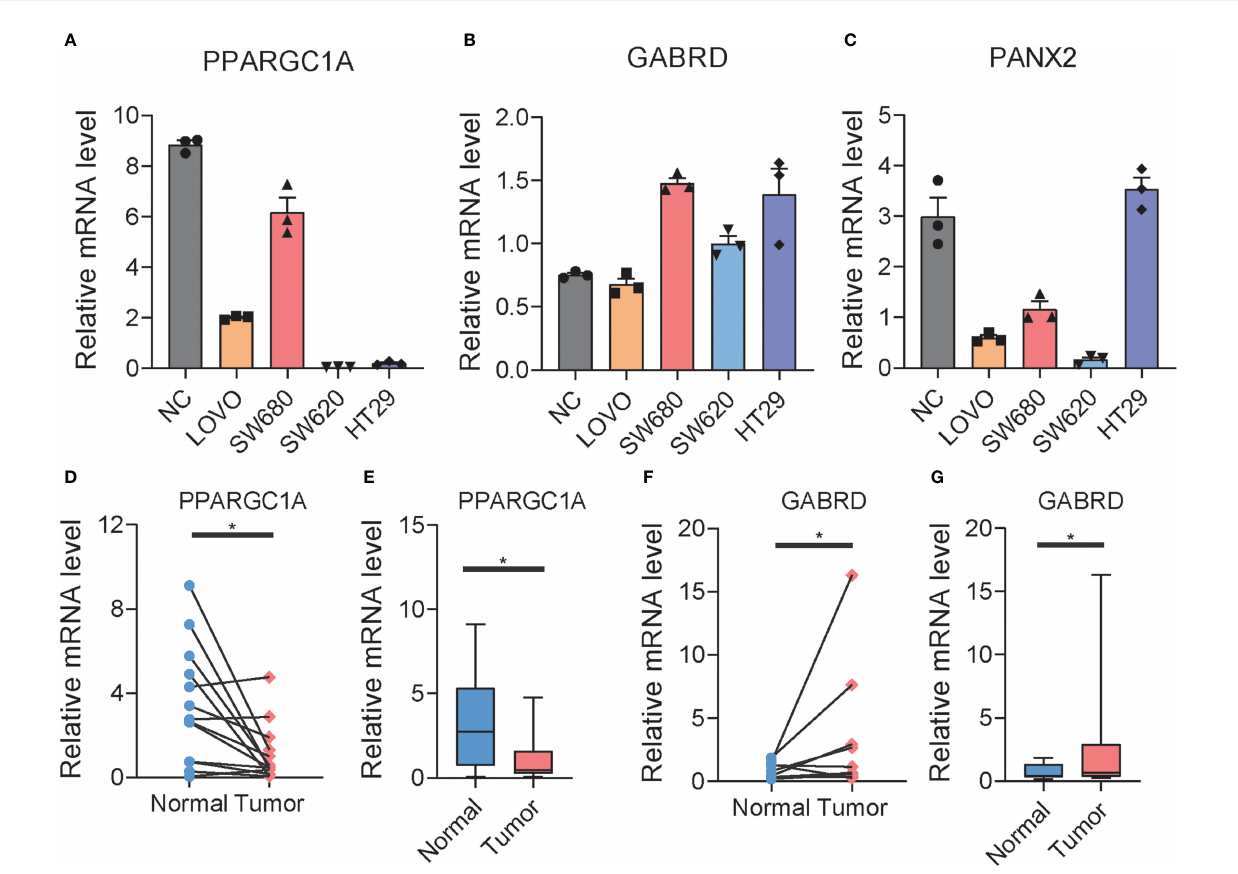
FIGURE 7 The expression of RRGs in colon cancer. (A – C) The expression of PPARGC1A, GABRD, and PANX2 in normal colon cell lines and differential colon cancer cell lines. (D – G) The expression of PPARGC1A and GABRD in normal colon tissue and tumor colon tissue of patients. t -test was used to compare the expression of genes between normal and tumor. * p <